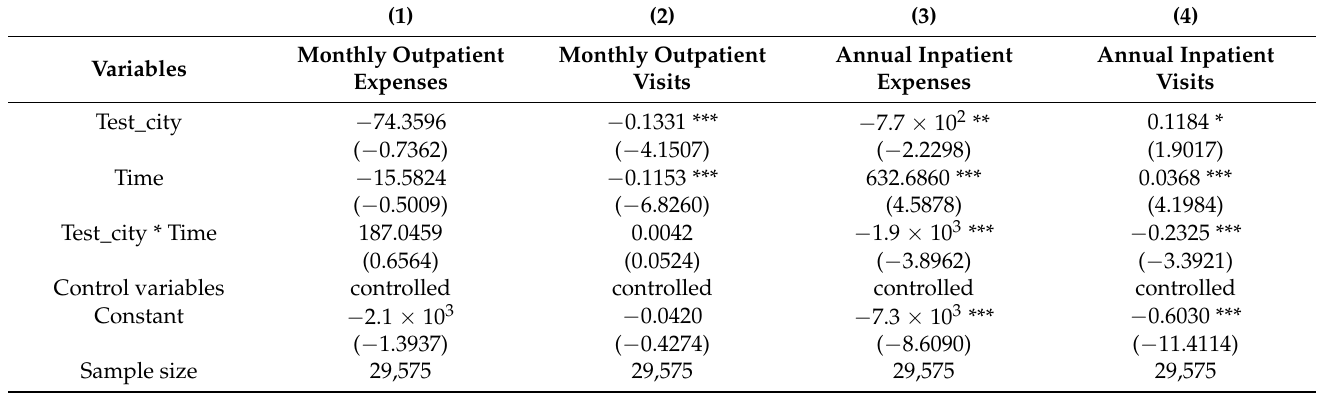
Table 7. DID results with kernel